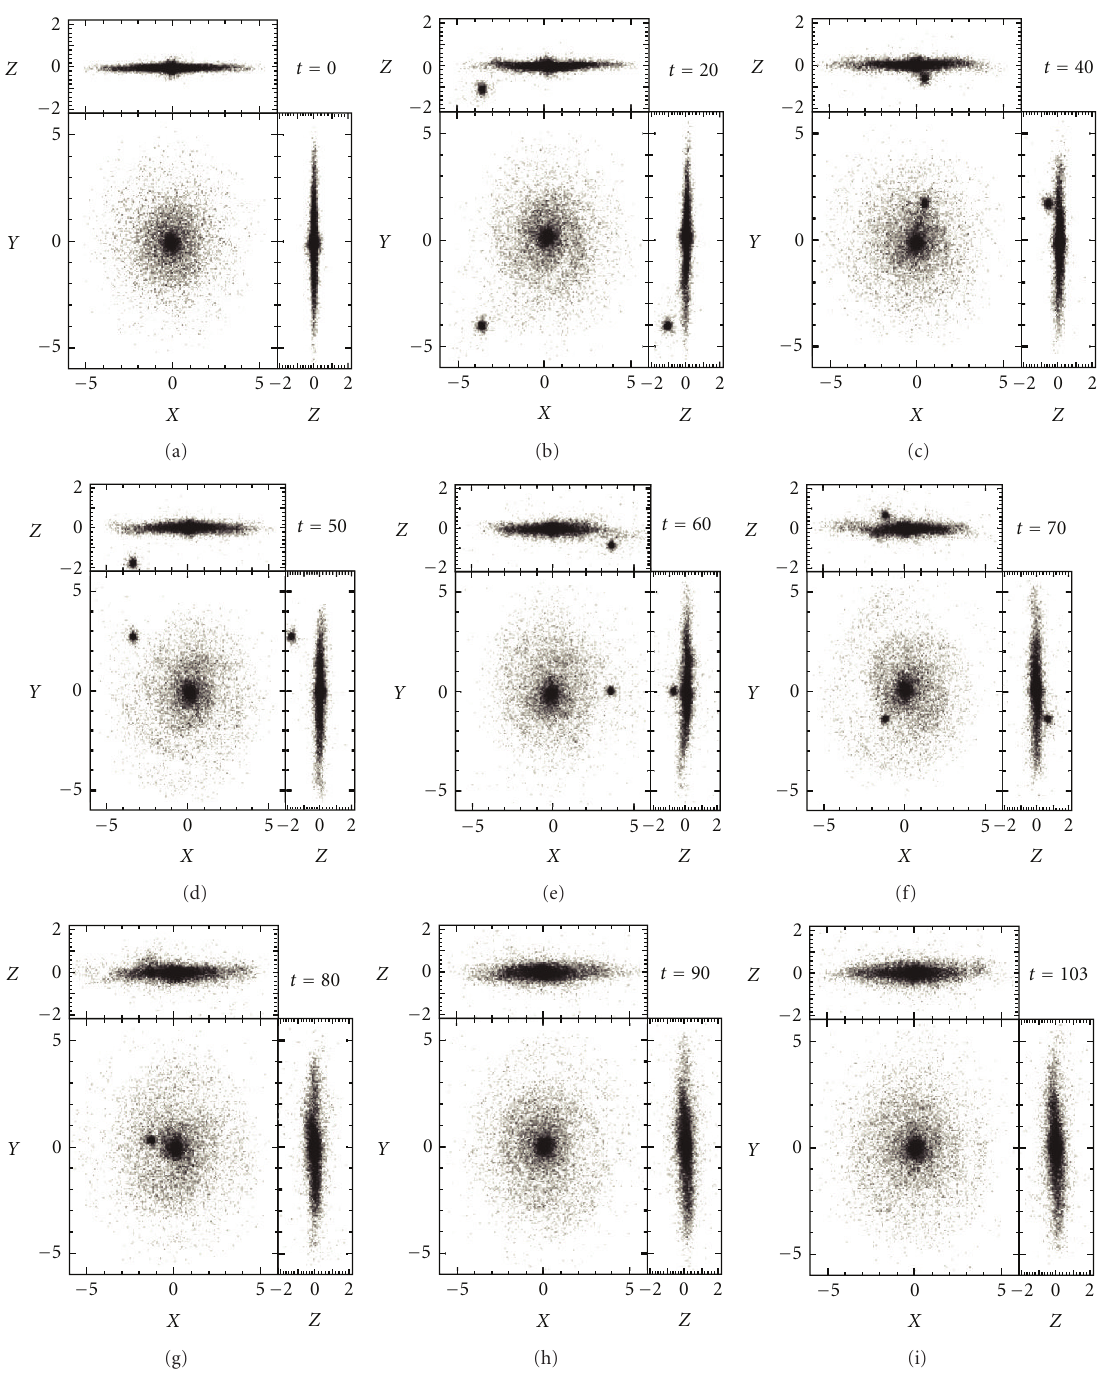
Figure 17: The time evolution of the luminous matter of a minor merger (see details in [243]).